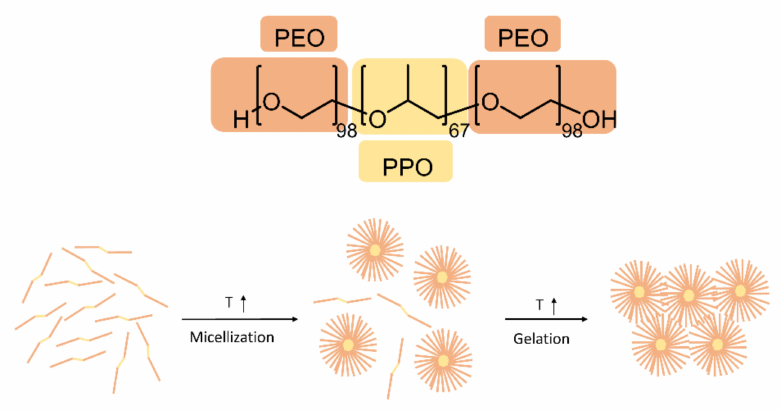
Figure 1. General structure of P407 and representation of micelles